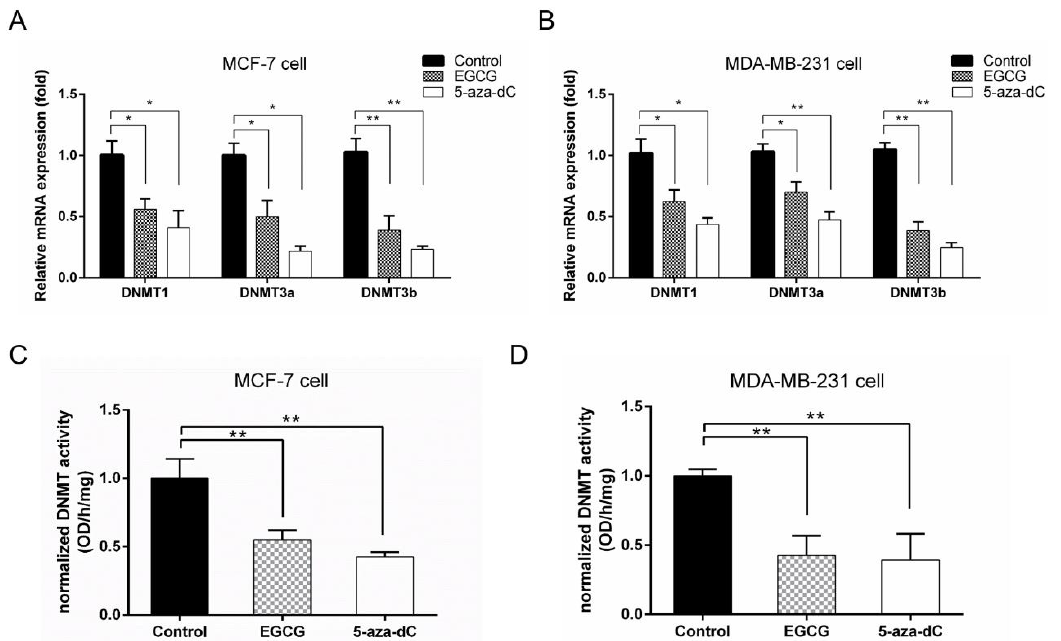
Figure 6. EGCG treatment decreased DNA methyltransferase (DNMT) expression and activity in breast cancer cells. The mRNA level of DNMT1, DNMT3a, and DNMT3b in MCF-7 ( A ) and MDA-MB-231 cells ( B ) treated with 20 µ M EGCG or 5 µ M 5-aza-dC. The results are presented as the expression